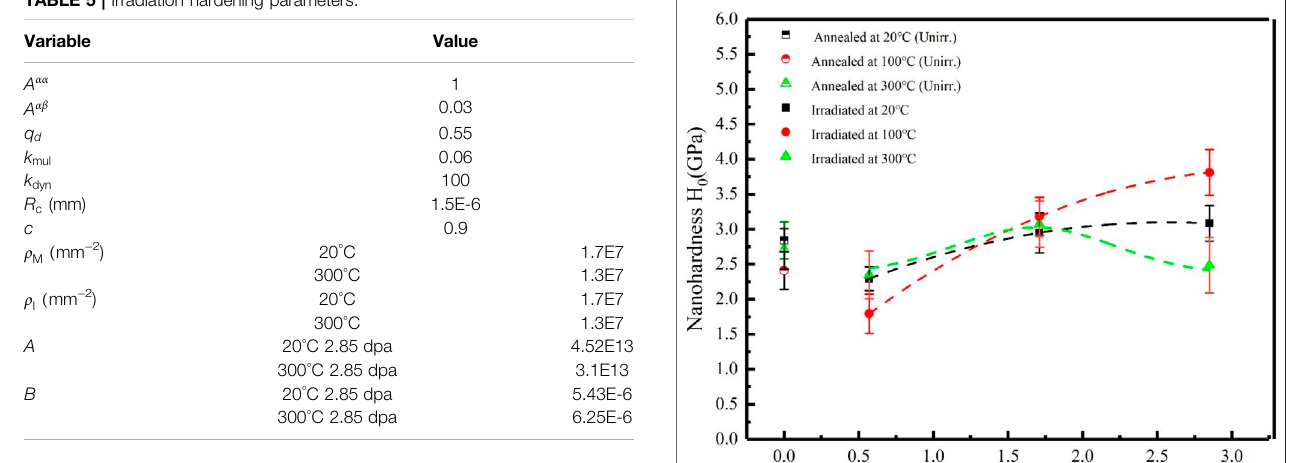
TABLE 5 | Irradiation hardening